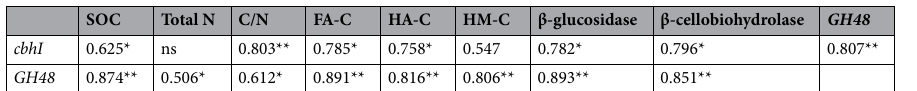
Table 3. Correlation coefficients between soil nutrient, humic C substances, enzyme activity and abundance of cbhI and GH48 genes in different particle-size fractions under different fertilizer treatments. SOC soil organic carbon, FA‑C carbon content of fulvic acid, HA‑C carbon content of humic acid, HM‑C carbon content of humin, ns no significant relationship were detected. * p < 0.05; ** p <